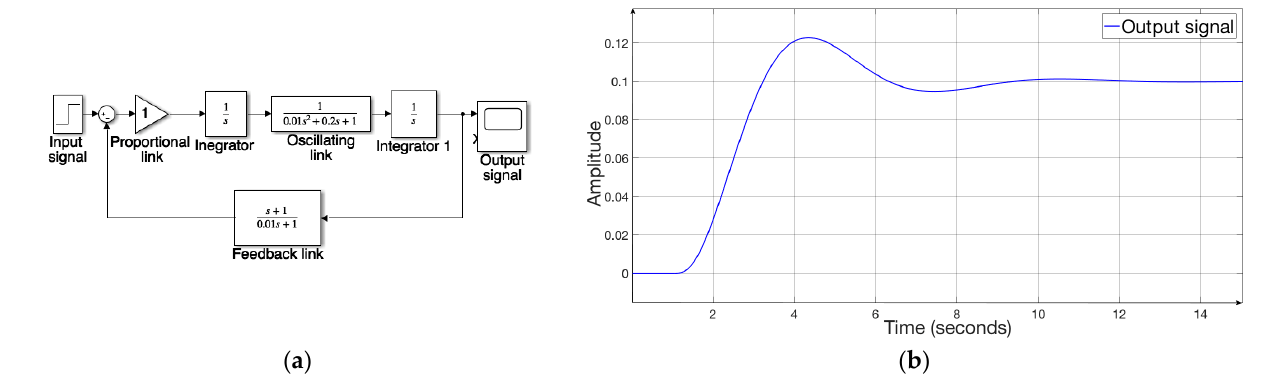
Figure 13. Scheme of a linear ACS of the 4th order ( a ) and simulation result ( b ).